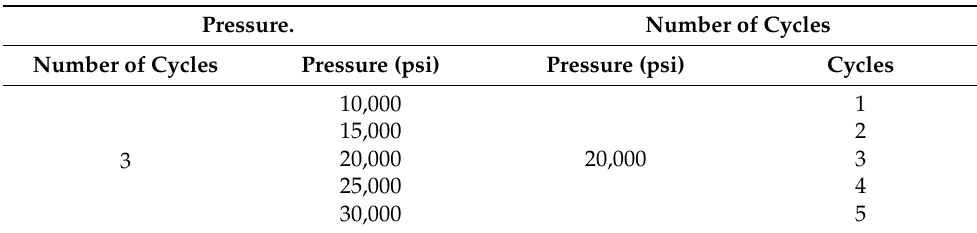
Table 2. Variations in homogenization pressure and number of cycles assessed while fabricating solid lipid